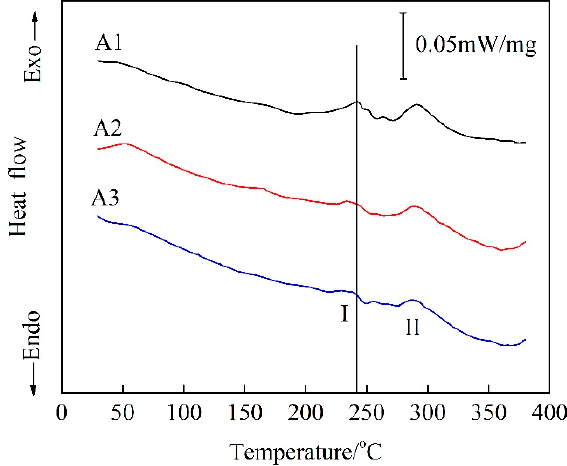
Figure 14. DSC curves of the alloys with PA treatment.